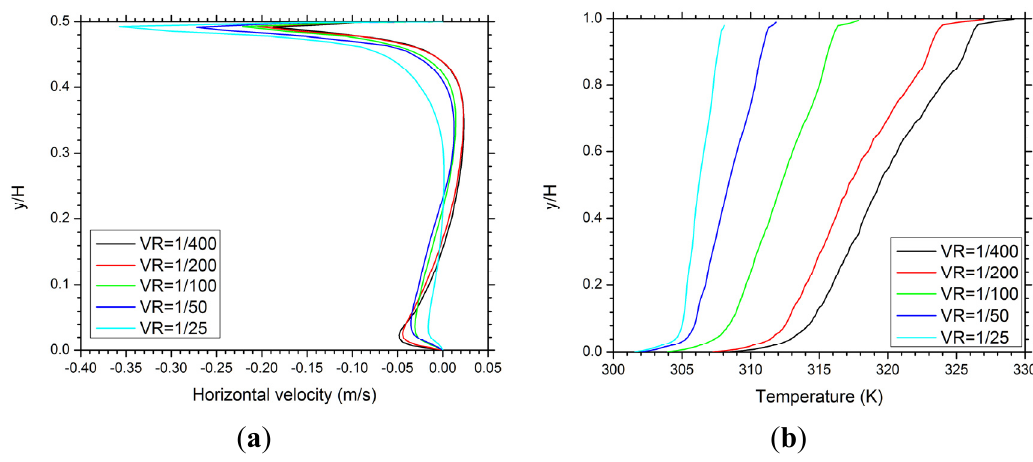
Figure 4. Predicted profiles of ( a ) horizontal velocity along the vertical line x = 2 m; and ( b ) temperature along the symmetric line x = 0 for attics with balanced ridge and soffit vents at various ventilation